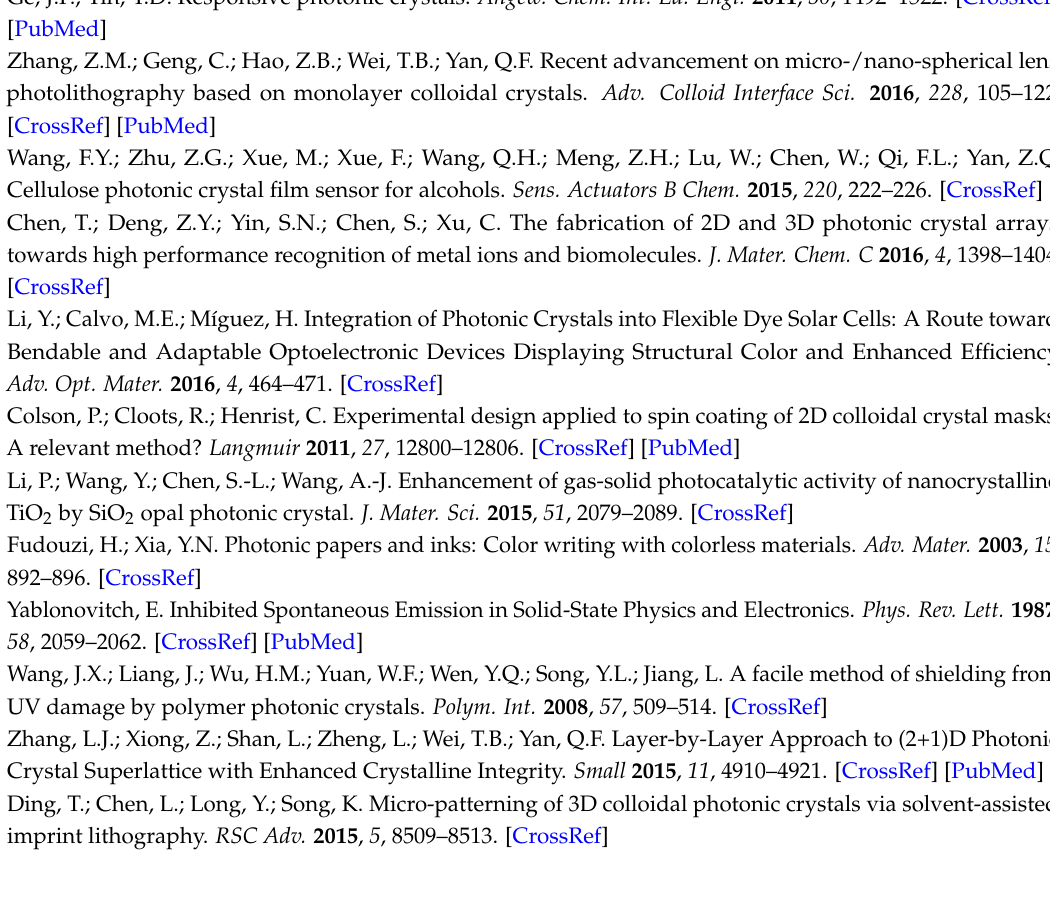
Figure S1: Optical microscope images of as-prepared sample, Figure S2: Scheme for the further investigation of the eye pattern PC, Figure S3: Optical microscope images and SEM images of as-prepared sample, Figure S4: SEM images of as-prepared eye-pattern sample after being peeling off the substrate, Figure S5: SEM images of cross-section of as-prepared sample, Figure S6: Reflection UV-vis spectra of different part of the peacock eye pattern